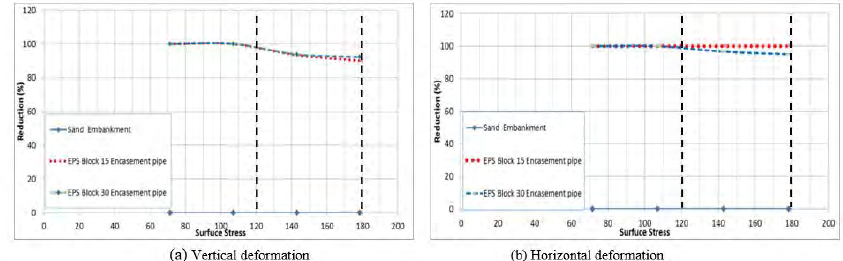
Figure 11. The reduction percentage of UPVC buried pipe in case of EPS encasement pipe methods.